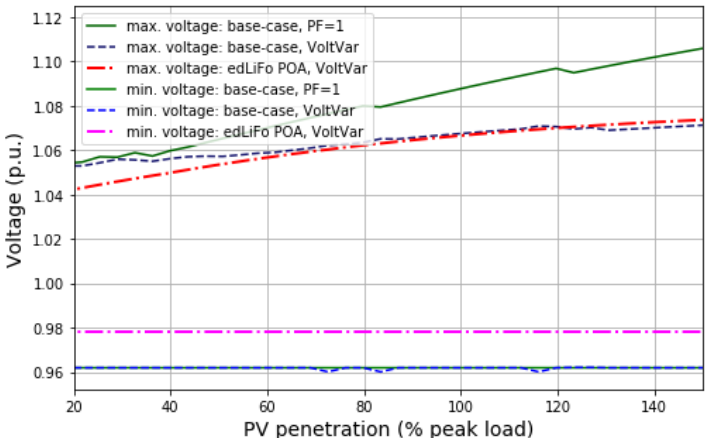
Figure 11. Voltage range per PV penetration by study case.